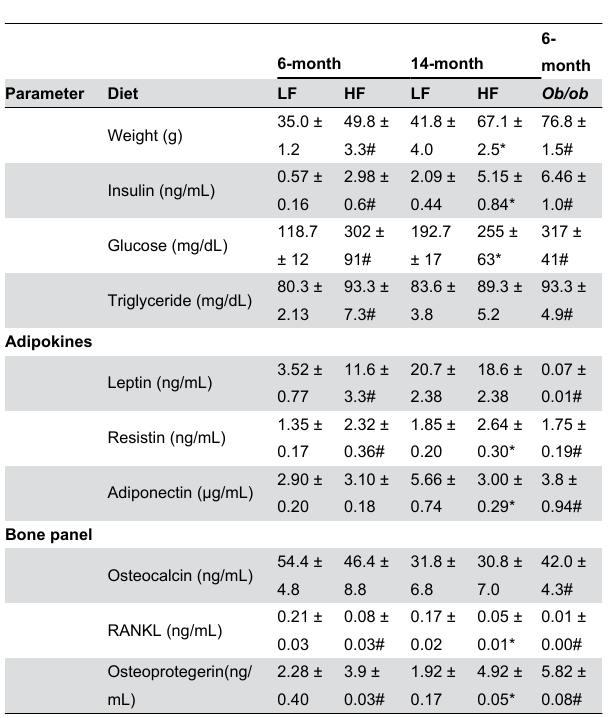
Table 1. Metabolic parameters in obese